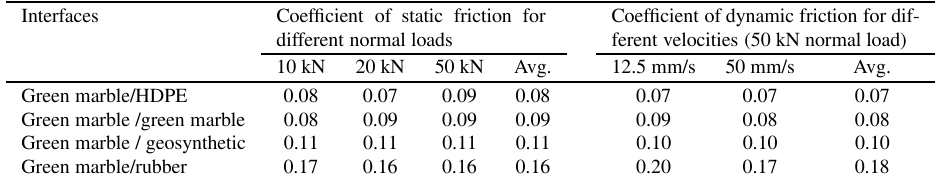
Table 1 Coef fi cient of friction for different sliding interfaces